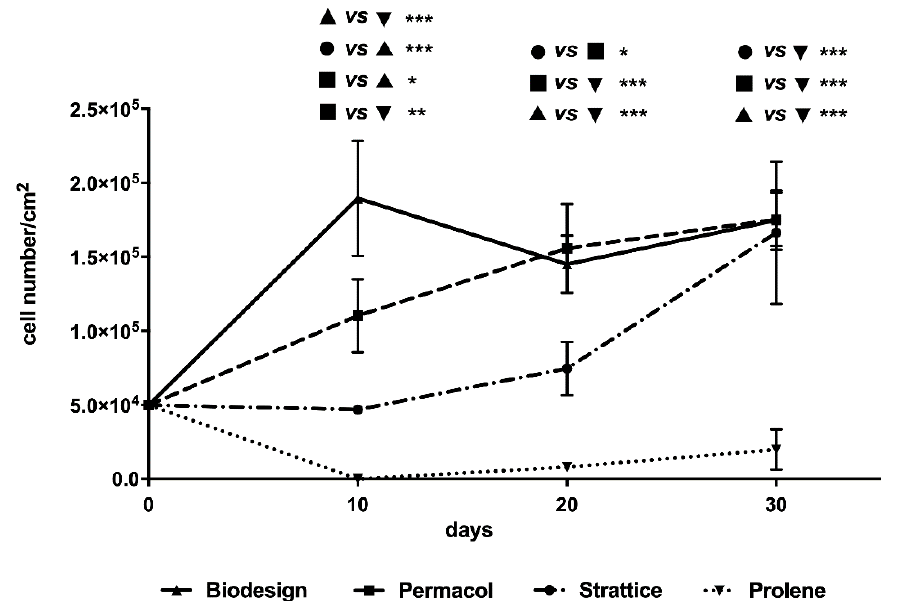
Figure 2. Growth of human dermal fibroblasts on tested matrices at 10, 20, and 30 days. Biodesign: line with upwards pointing triangles; Permacol: dashed line with squares; Strattice: dash-dot line with circles; Prolene: dotted line with downwards pointing triangles. Average number of cells ( ± SE) obtained at each time point with two methods (Cell Titer Glo Promega kit and manual count after detachment with an enzymatic cocktail) in three independent experiments were analyzed with analysis of variance (ANOVA) using a post-hoc Bonferroni test. Asterisks indicate significant differences (* p < 0.05; ** p < 0.01; *** p <